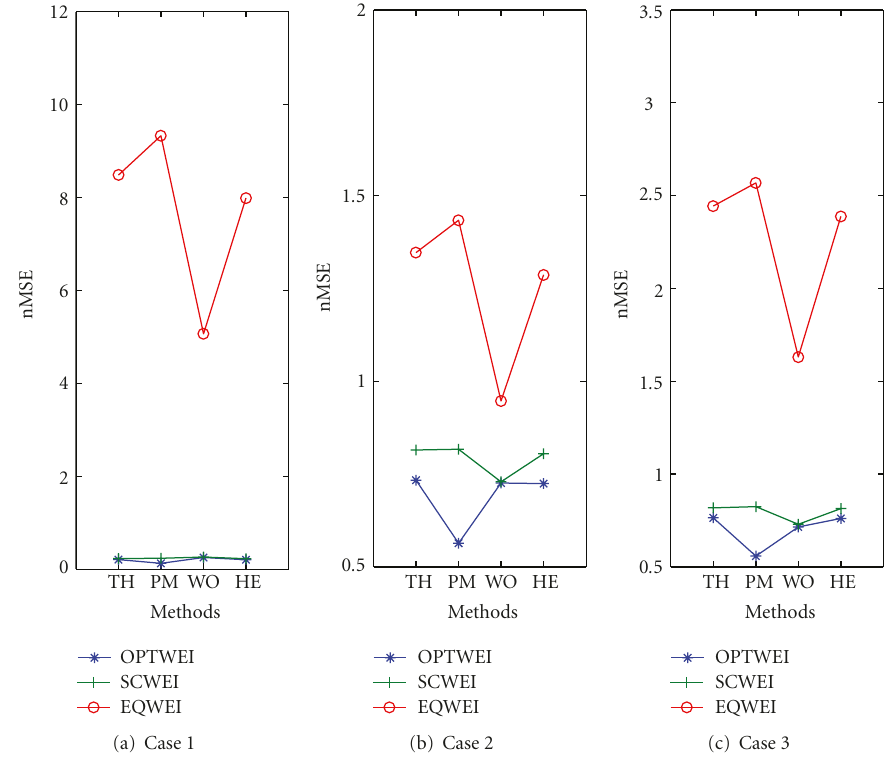
Figure 4: The normalized mean square error for the three bandlimited peaked spectrum processes with EQWEI (circles), SCWEI (pluses), and OPTWEI (stars) for di ff erent window sets, Thomson multiple windows (TH), Peak-Matched multiple windows (PM), Welch method (WO) and Hermite functions (HE): (a) stationary process, (b) long-event nonstationary process, and (c) short-event nonstationary